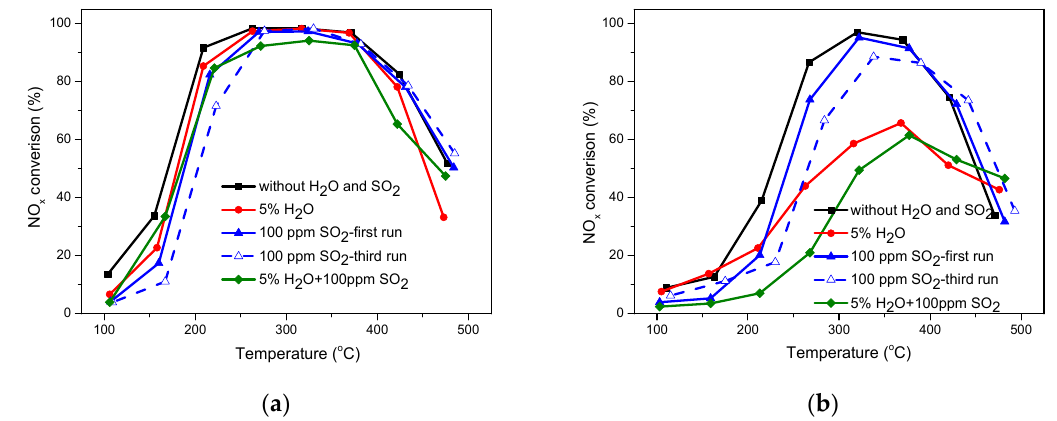
Figure 2. Effect of H 2 O and SO 2 on the NH 3 -SCR performance over ( a ) the SbCeZr catalyst and ( b ) the SbCe catalyst (reaction conditions: 500 ppm NO, 500 ppm NH 3 , 5% O 2 , 5% H 2 O, 100 ppm SO 2 , with Ar balance).